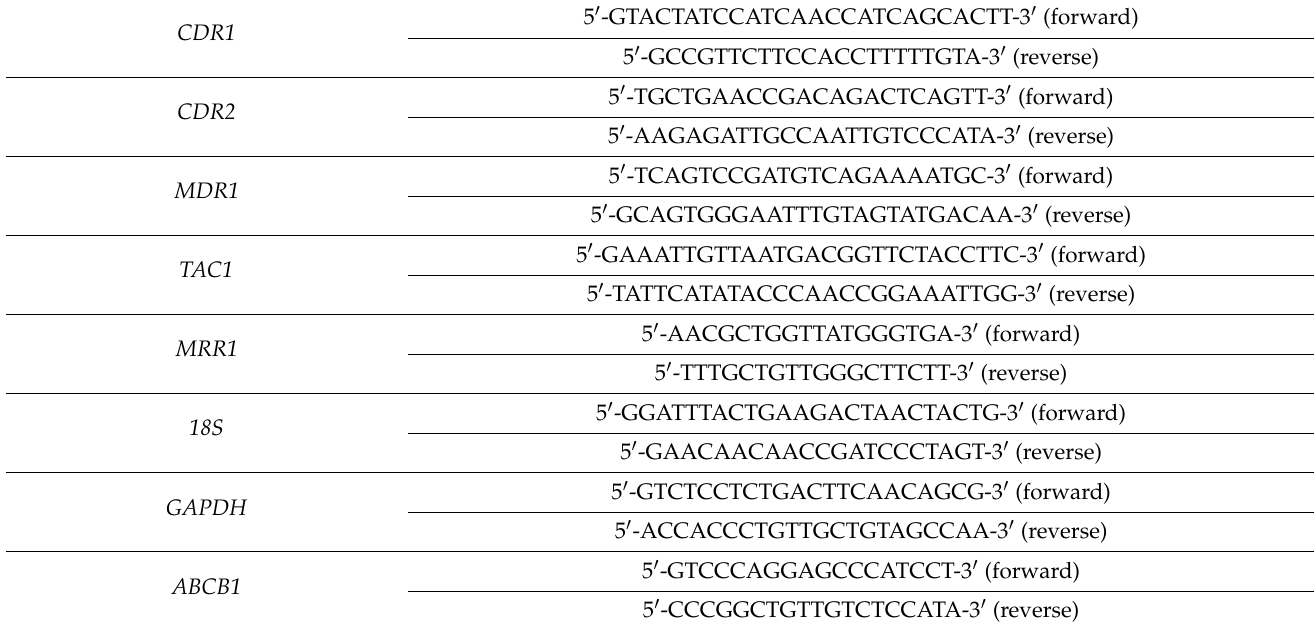
Table 1. Primers used in the